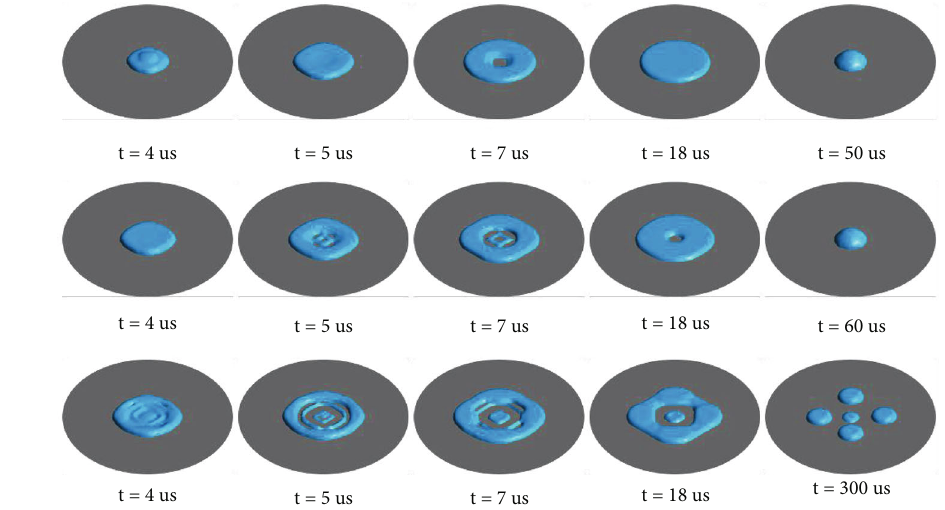
Figure 5: Spreading process of the droplet with a diameter of 10 μ